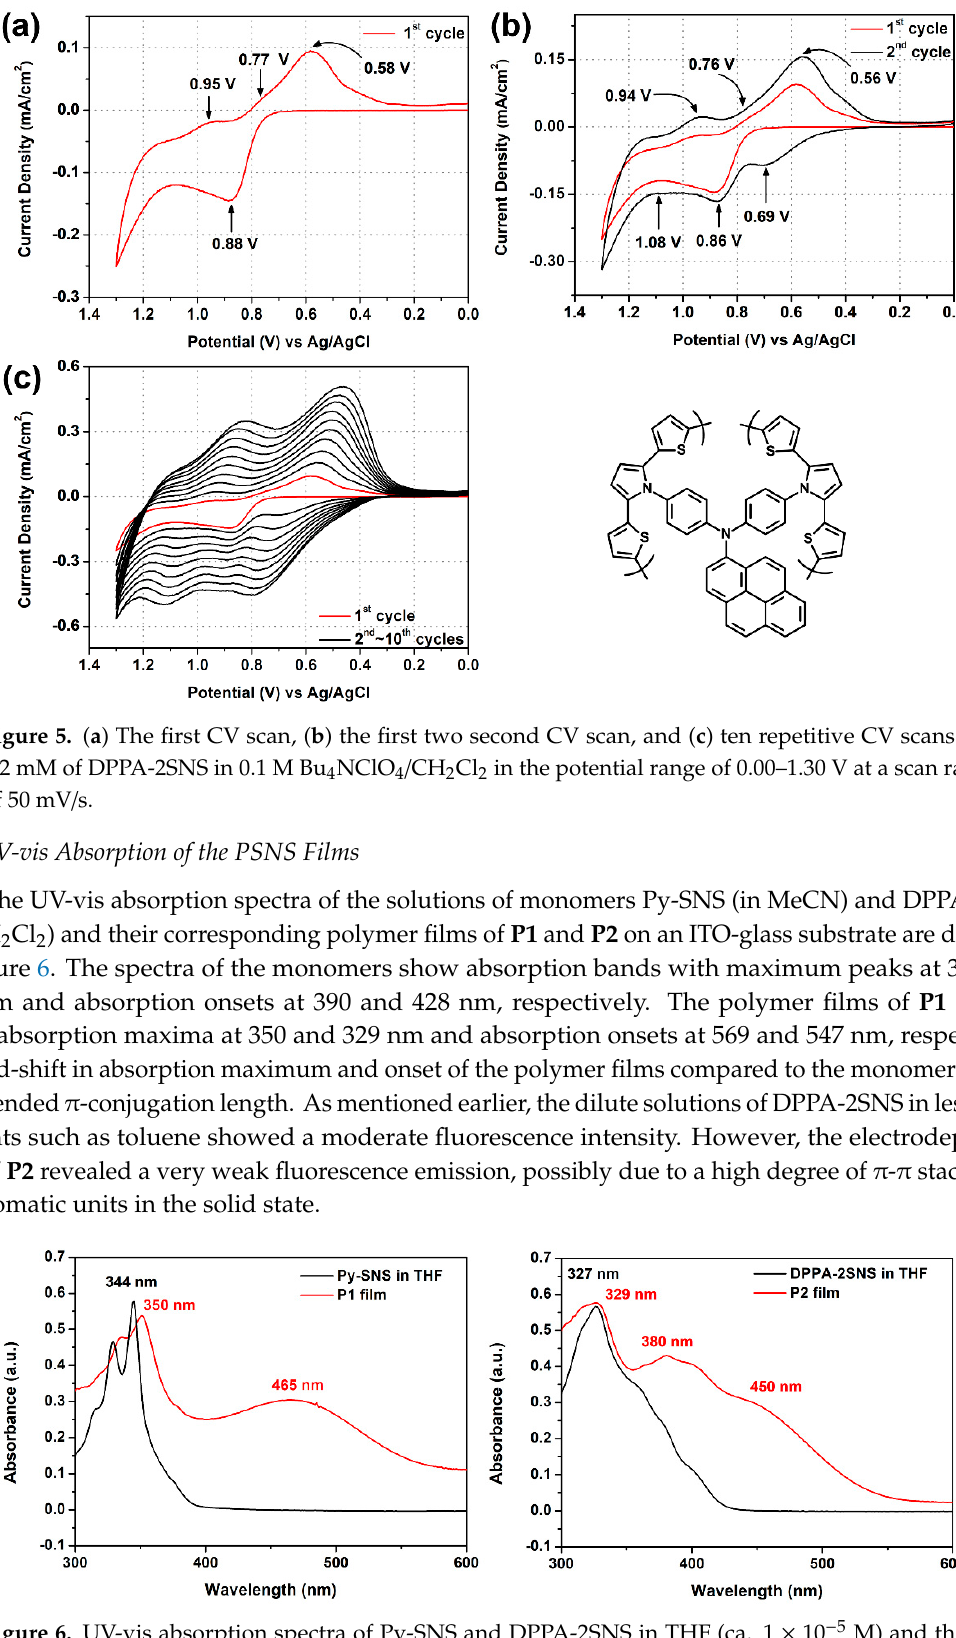
Figure 4. ( a ) The first CV scan, ( b ) the first two second CV scan, and ( c ) ten repetitive CV scans of 0.2 mM of DPPA-2SNS in 0.1 M Bu 4 NClO 4 /CH 2 Cl 2 in the potential range of 0.00–1.10 V at a scan rate of 50 mV/s.